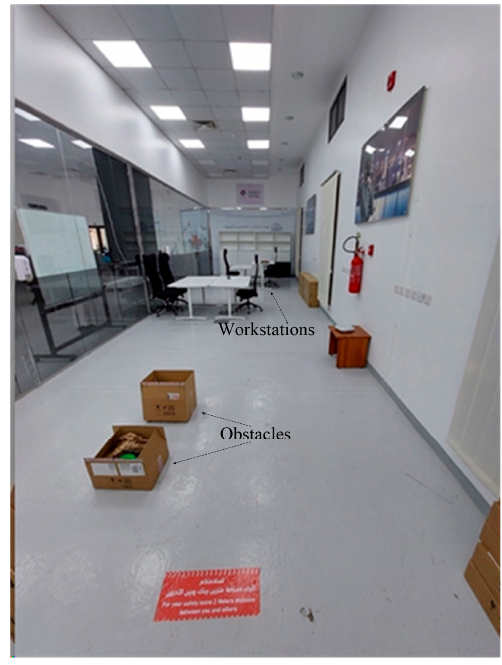
Figure 3. Side view of Area 1 (study area).